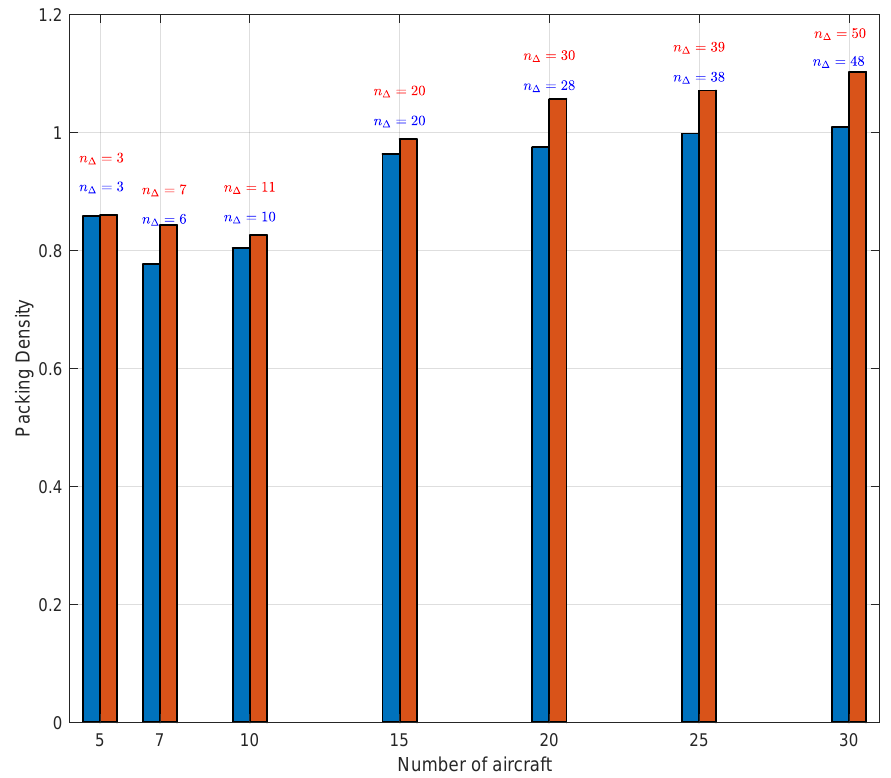
Figure 30. Minimum (blue bars) and maximum swarm packing densities (red bars) in the absence of obstacles. n ∆ describes the number of triangles in a DTG. The values close to 1 highlight the efficiency of the Delaunay-based swarm guidance